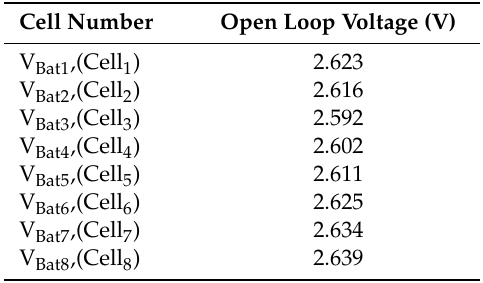
Table 3. Open loop voltage for discharged cells in the test battery string.